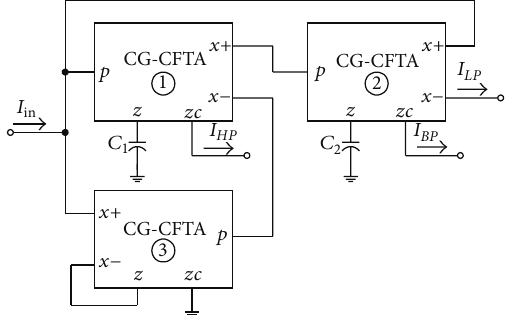
Figure 13: Current-mode KHN filter using CG-CFTAs.